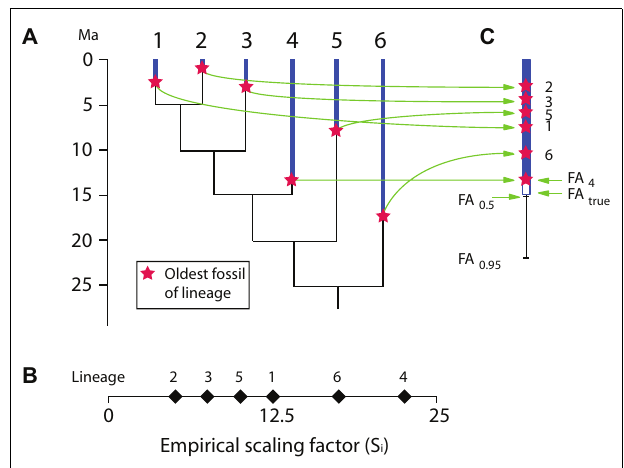
FIGURE 5 | Hypothetical example illustrating the basic principles of Marshall’s (2008) method for calculating confidence intervals on the appearance of taxa based on their fossil record and an uncalibrated ultrametric molecular tree. (A) Ultrametric molecular tree with stratigraphic range of known fossil record of each terminal branch. (B) Empirical scaling factor (S i ) for each of the six terminal lineages. In this hypothetical example, the true (unknown) root age is 25 Ma. (C) Same, shown vertically, along with the 50 and 95% confidence intervals on the first appearance (FA) of the lineage with the highest S i (lineage 4) if we assume that a single fossiliferous horizon is known for each of the six terminal lineages.